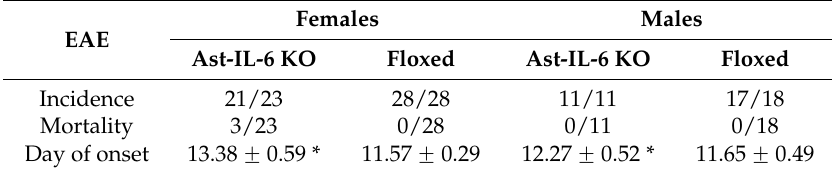
Table 2. EAE disease.